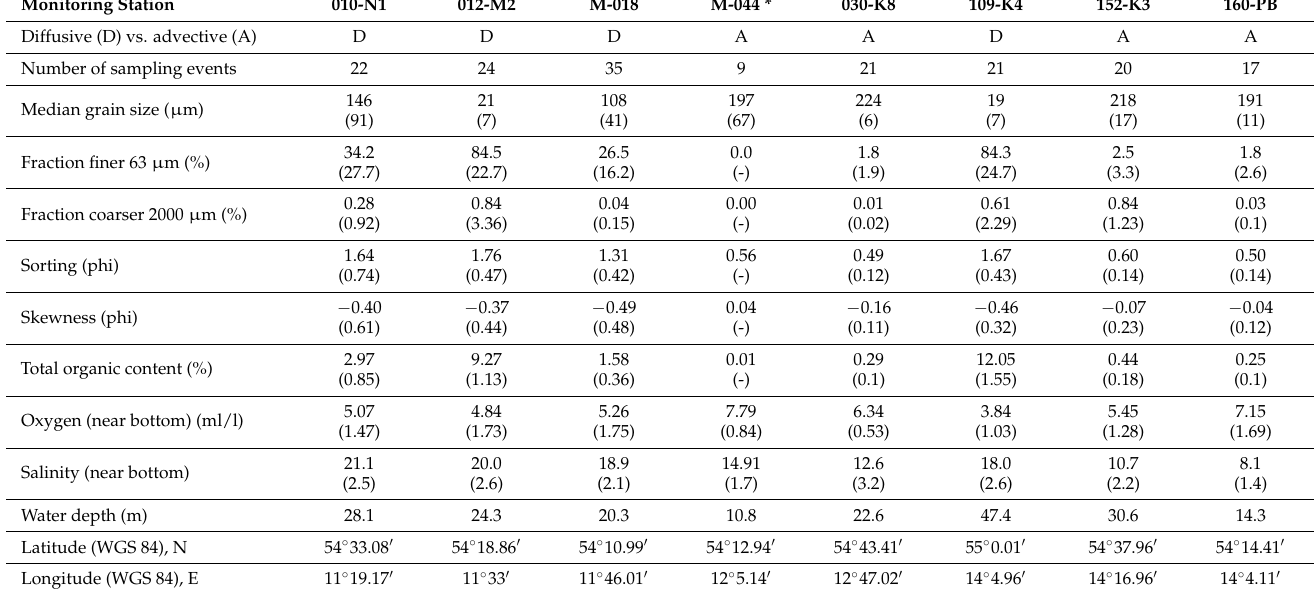
Table 1. Average values of sediment and environmental variables measured at monitoring stations, observed in the period 2000–2020. In brackets, values of standard deviation (SD) are reported. For station M-044 marked with *, SD could not always be defined, as multiple measurements of sediment and environmental variables were missing; this station was only sampled in the years